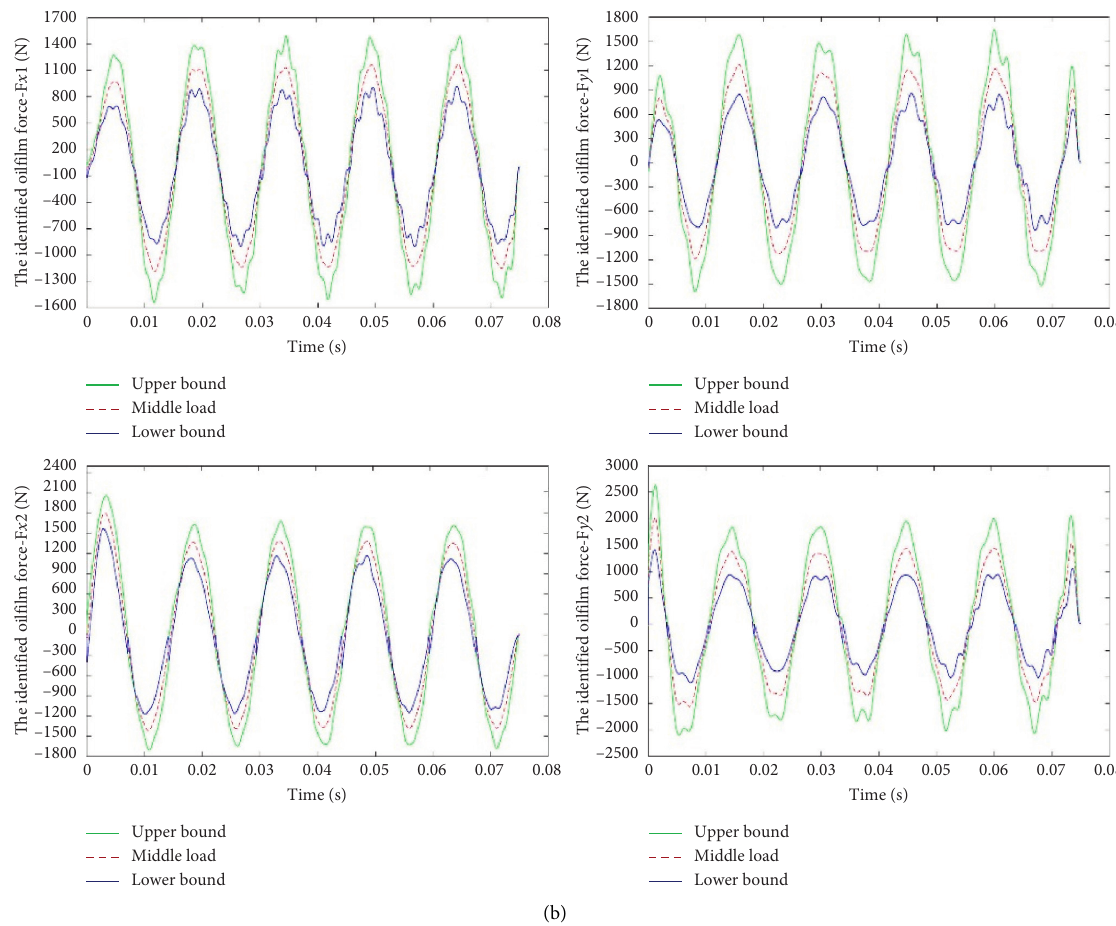
Figure 6: The identified uncertain bearing load: (a) the sensitivity curve of the bearing load to probabilistic parameters; (b) identified bearing load boundary at 3% uncertainty